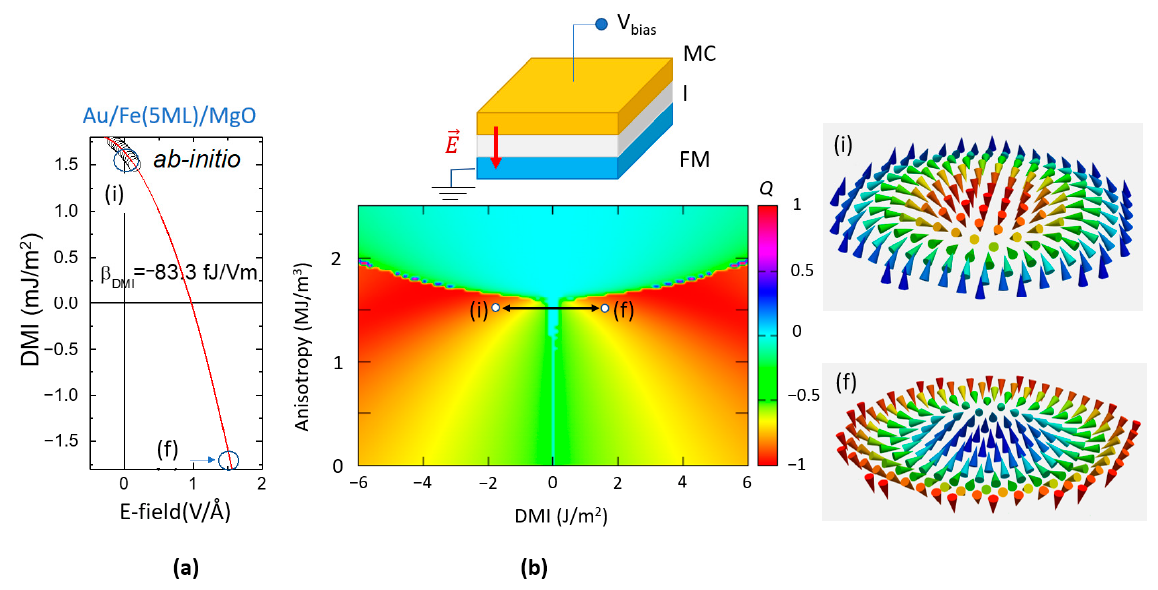
Figure 27. ( a ) Ab-initio calculated DMI variation with the electric field. The variation rate is described by the parameter β = ∆ E − field (fJ/Vm). ( b ) DMI-PMA-Q phase diagram in which we indicated the path between the initial (i) and the final (f) states showing opposite core polarization and chirality. Top insert: sketch of E-field biasing geometry, the electric field at the surface of the ferromagnetic layer (FM) is applied across an insulator (I) using a top metallic contact electrode (MC).